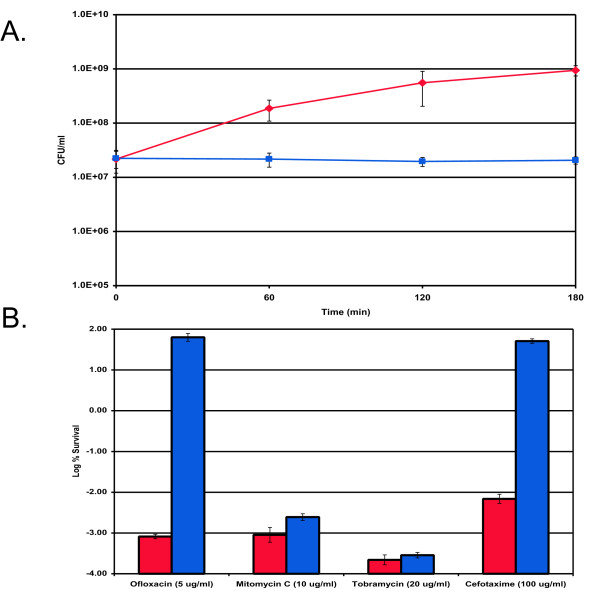
Effects of ygiU overexpression on persister formation. E. coli MG1655 cells were grown in LB medium to mid-exponential phase (~5 × 107 cells/ml) at 37°C with aeration. (A) ygiU expression was induced (squares) from pTOX at T = 0 by the addition of 1 mM arabinose, and MG1655 with a blank vector (pBAD33) served as the control (diamonds). (B) Cells were cultured, and ygiU expression was induced as described in (A). After 2 h of ygiU induction, samples were removed and treated with either cefotaxime (100 μg/ml), mitomycin C (10 μg/ml), ofloxacin (5 μg/ml), or tobramycin (20 μg/ml) for 3 h at 37°C with aeration. The control (MG1655/pBAD) (red bars) was challenged at a cell density similar to that of the ygiU induced cells (blue bars).